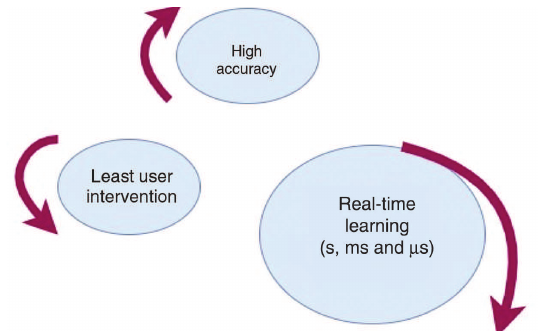
Figure 1: Essential Considerations of ELM.